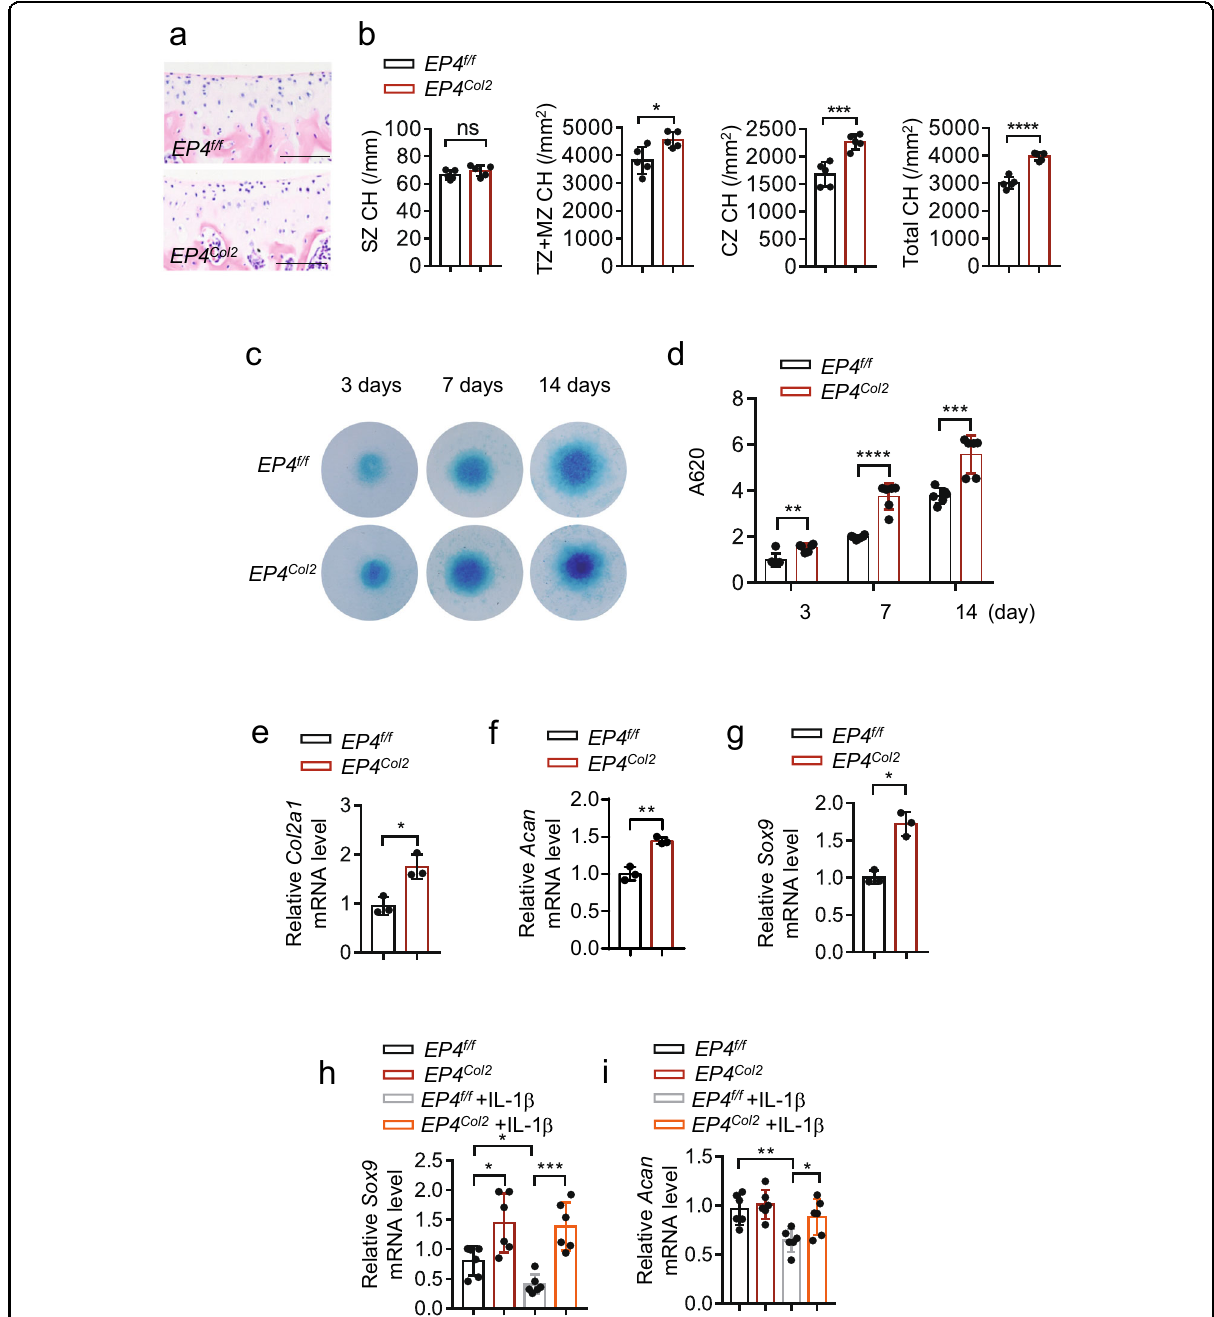
Fig. 3 EP4 regulates chondrocyte differentiation and chondrocyte anabolism. a , b H&E staining of femoral articular cartilage from EP4 f/f and Ep4 Col2 mice at 3 months of age ( a ). Scale bar, 50 μ m. Chondrocyte numbers (CH) were calculated in super fi cial zone (SZ), transition, and middle zones (TZ + MZ), calci fi ed zone (CZ), and entire femoral articular cartilage quanti fi ed (Total CH) ( b ). n = 5 mice per group. c , d Primary articular chondrocytes were isolated from Ep4 Col2 knee joints of new born pups. Micromass of the chondrocytes cultured in the chondrogenic media for 3, 7, and 14 days were stained with Alcian blue ( c ). Alcian blue-stained cultures were quanti fi ed ( d ). Error bars are means ± s.d., n = 6. ** P < 0.01, *** P < 0.001, **** P < 0.0001 by by two-way ANOVA with multiple comparison using Sidak method. e – g qRT-PCR analyses of Acan, Col2a1 , and Sox9 expression in primary articular chondrocytes of EP4 f/f and Ep4 Col2 and 7 days after chondrogenic differentiation. Error bars are means ± s.d., * P < 0.05, ** P < 0.01 by student t -test. h , i qRT-PCR analyses of Acan and Sox9 expression in primary articular chondrocytes from EP4 f/f and Ep4 Col2 mice treated with IL-1 β for 24 h. Error bars are means ± s.d., n = 6, * P < 0.05, ** P < 0.01, *** P < 0.001 by one-way ANOVA with multiple comparison using Tukey